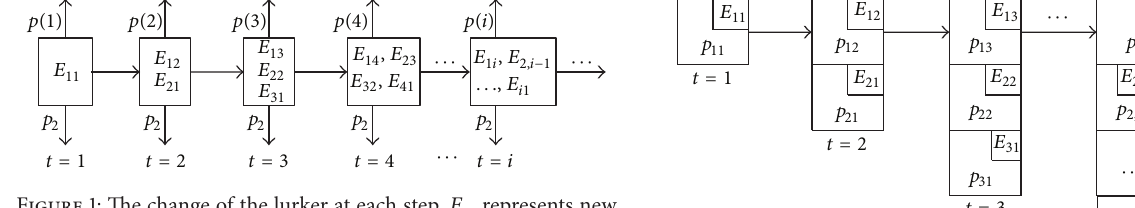
Figure 1: The change of the lurker at each step. 𝐸 𝑖1 represents new lurkers at the 𝑖 th time step and 𝐸 𝑖𝑗 ( 𝑗 ̸= 1 ) represents the j th residual of 𝐸 𝑖1 . The total number of lurkers is 𝐸(𝑖) = 𝐸 𝑖1 +𝐸 𝑖−1,2 +𝐸 𝑖−2,3 +⋅⋅⋅+ + 𝐸 𝑖 th time step. For example, 𝐸(3) = 𝐸 𝐸 2,𝑖−1 1𝑖 at the